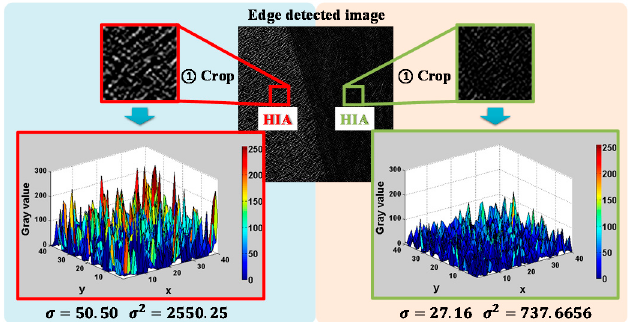
Figure 6. Examples of calculating the parameter (variance) required for the calculation of the amplitude of the carrier wave.